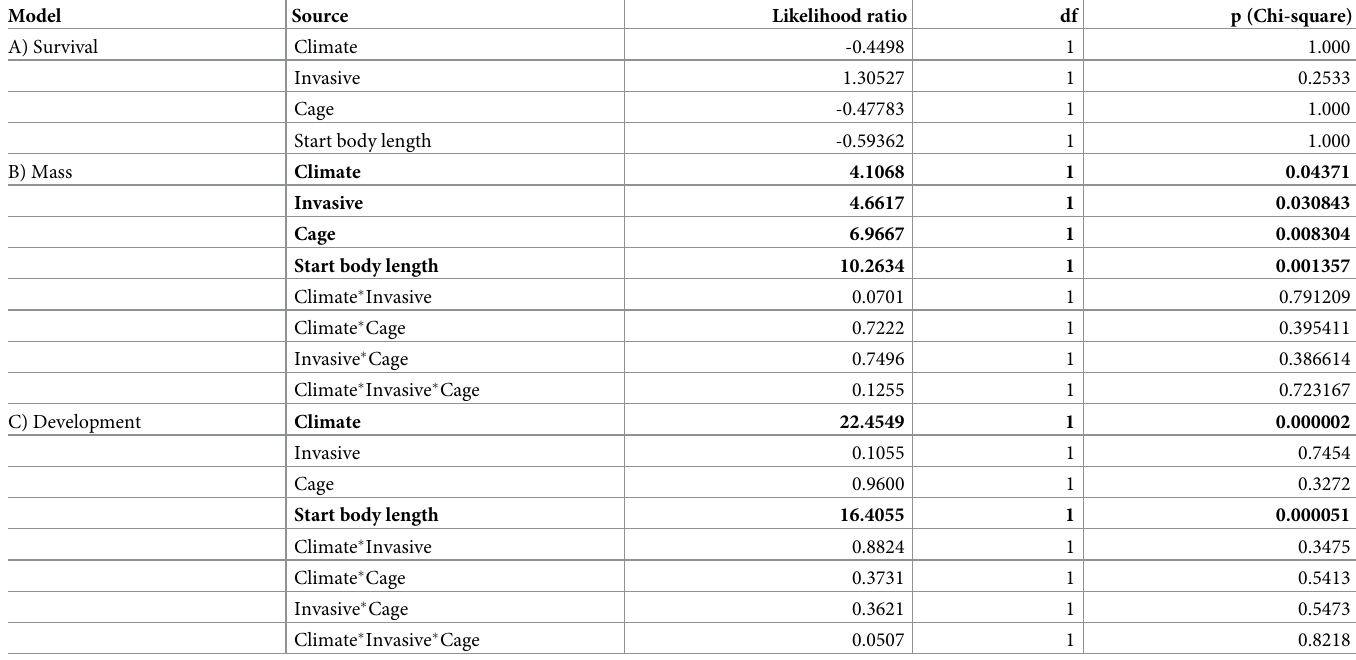
Table 1. Analysis of deviance table for all generalized linear regression models of treatment effects on survival, mass, and development.